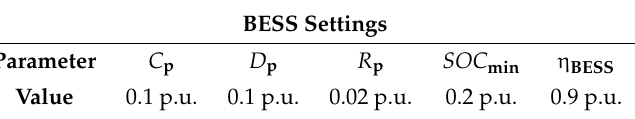
BESS settings: maximum charging active power ( C p ); maximum discharging active power ( D p ); recovery active power ( R p ); minimum allowed SOC ( SOC min ); and overall efficiency of the BESS ( η BESS ). BESS Settings Parameter